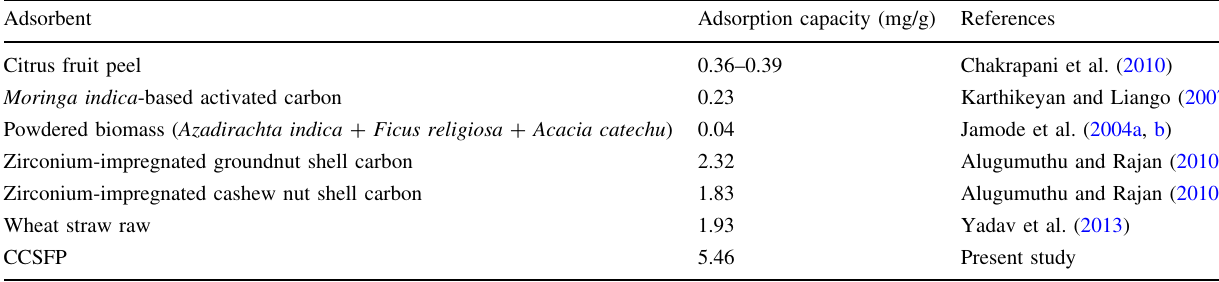
Table 7 Adsorption capacities for removal of fluoride using different adsorbents Adsorbent